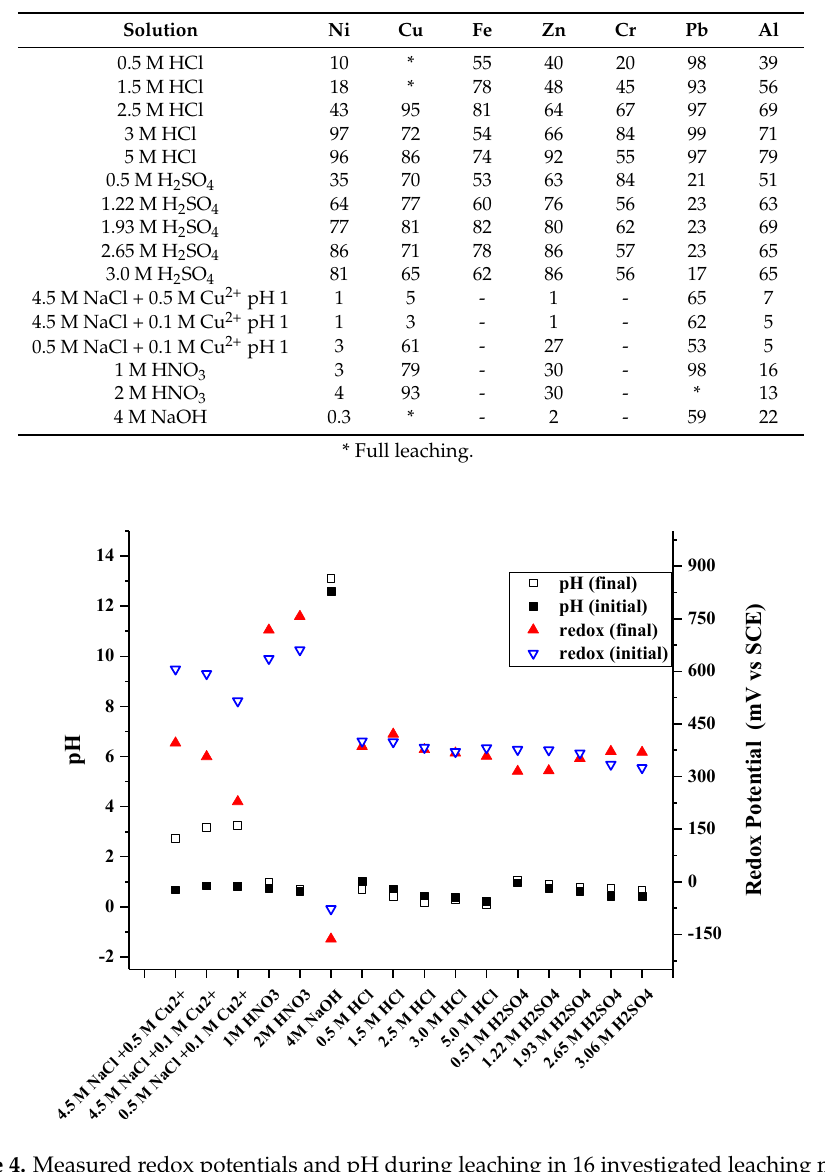
Figure 4. Measured redox potentials and pH during leaching in 16 investigated leaching media.